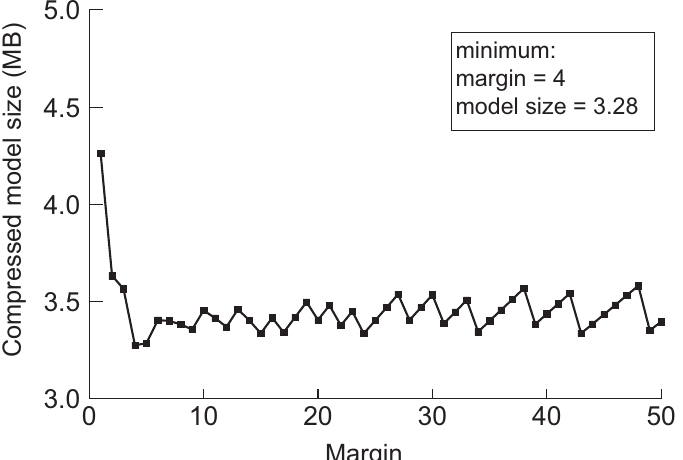
Figure 9. The minimum model sizes derived by the proposed method when the initial margin is varied from 1 to 50 for DenseNet-121 when the target accuracy is 94%.